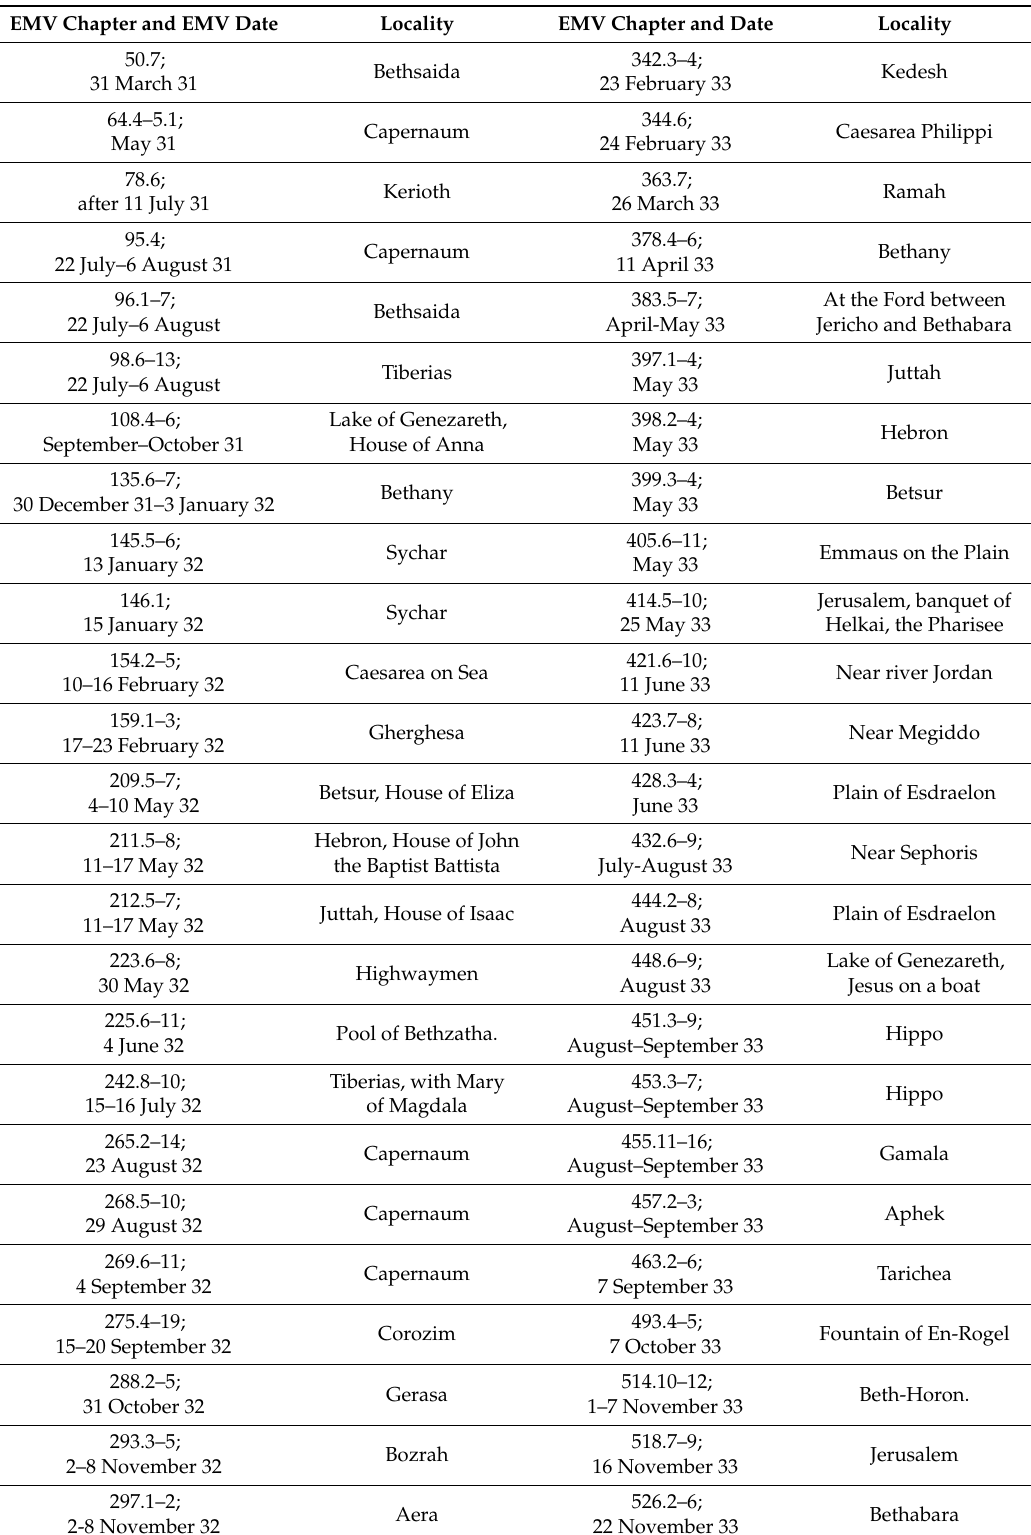
Table A2. Date, locality, a brief mention of the topic and setting of the speeches delivered in villages of Palestine (50